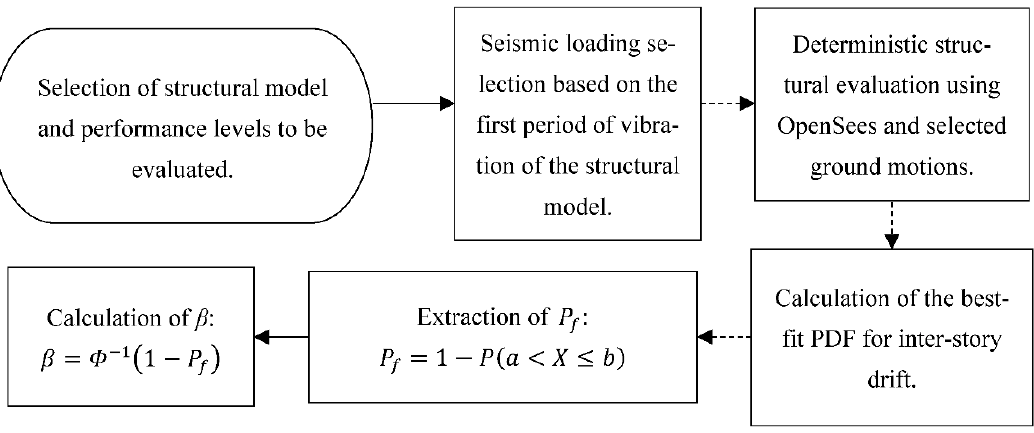
Figure 2. Flowchart of the alternative probabilistic approach.